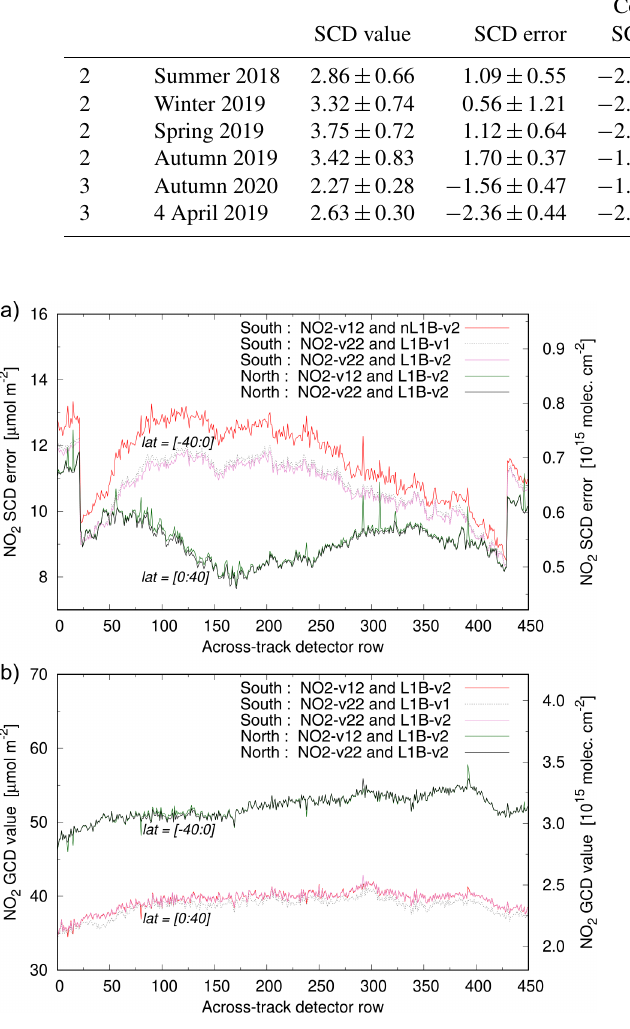
Figure 4. Relative differences in the DOAS retrieval results be- tween the TROPOMI DDS and OFFL data, averaged over the 30 ◦ tropical latitude region during the full DDS-2 winter 2019 (a) and DDS-3 autumn 2020 (b) periods (cf. Table 1), as a function of the Equator-crossing longitude of the orbits. The overall averages are listed in the legend and in Table